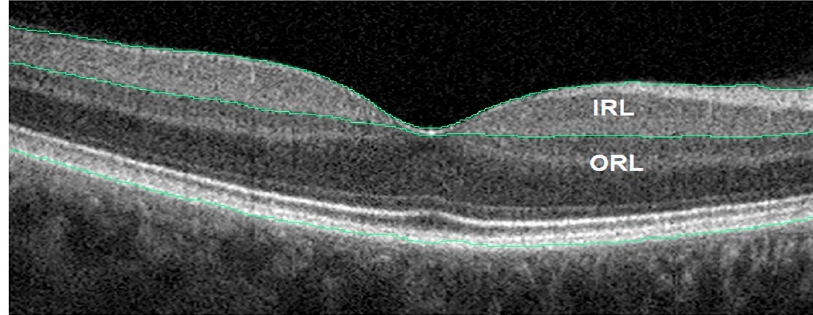
Figure 6. AD patient OCT image. Inner and outer retinal layer (IRL and ORL) [52].